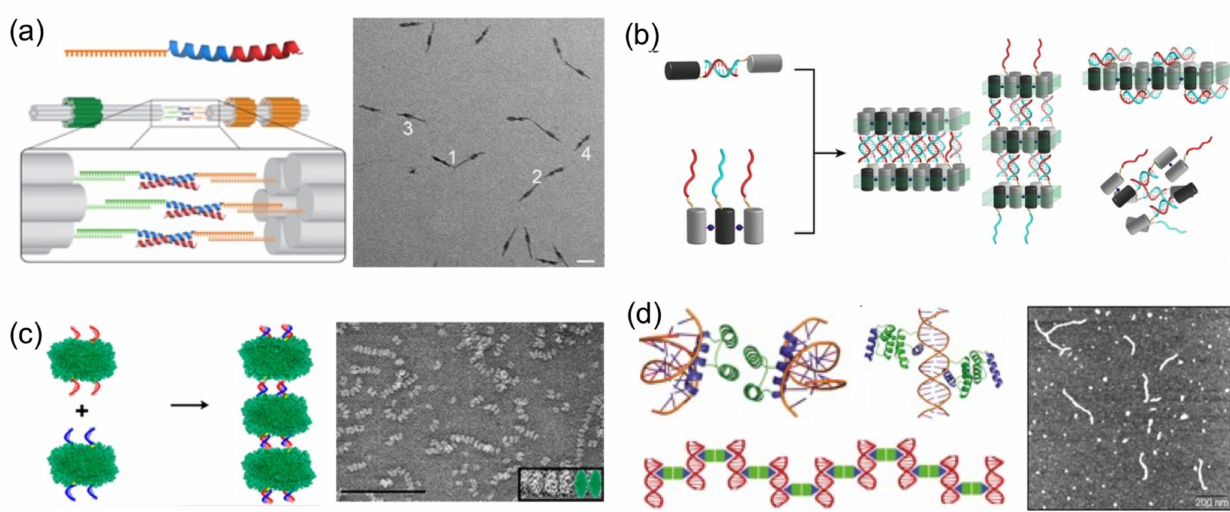
Figure 4. Polymerizing proteins and DNA into 1D nanostructures. ( a ) Coiled-coils conjugated to oligonucleotides (top left) dimerize DNA origamis (bottom left). TEM image is shown (right). Scale bar: 50 nm. Adapted from [23], with permission from American Chemical Society, 2019. ( b ) Metal-mediated proteins conjugated to DNA oligonucleotides self-assemble into 1D DNA assemblies. Reprinted from [22], with permission from American Chemical Society, 2018. ( c ) Enzime β -galactosidase conjugated to complementary oligonucleotides on opposing faces polymerize into elongated nanostructures (left). TEM image (right). Scale bar: 200 nm. Reprinted from [19], with permission from American Chemical Society, 2018. ( d ) Rationally designed protein with dual protein–protein and protein–DNA interactions self-assembles into nanorods (left). TEM image (right). Adapted from [33], with permission from Springer Nature,